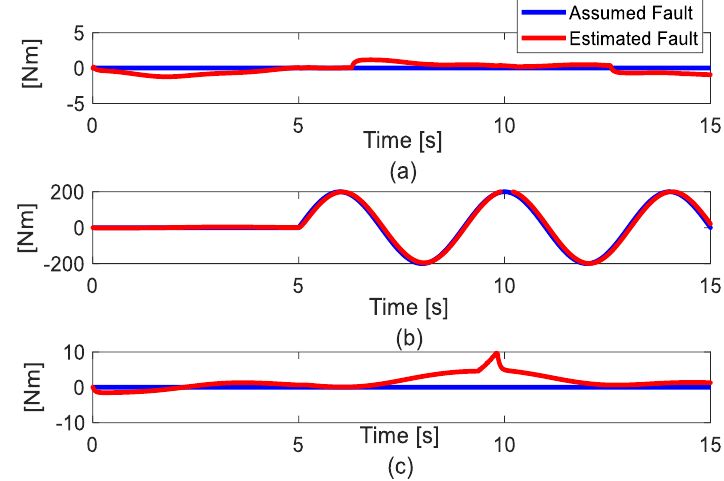
Figure 2. Fault estimation results. ( a ) Joint 1; ( b ) Joint 2; ( c ) Joint 3.